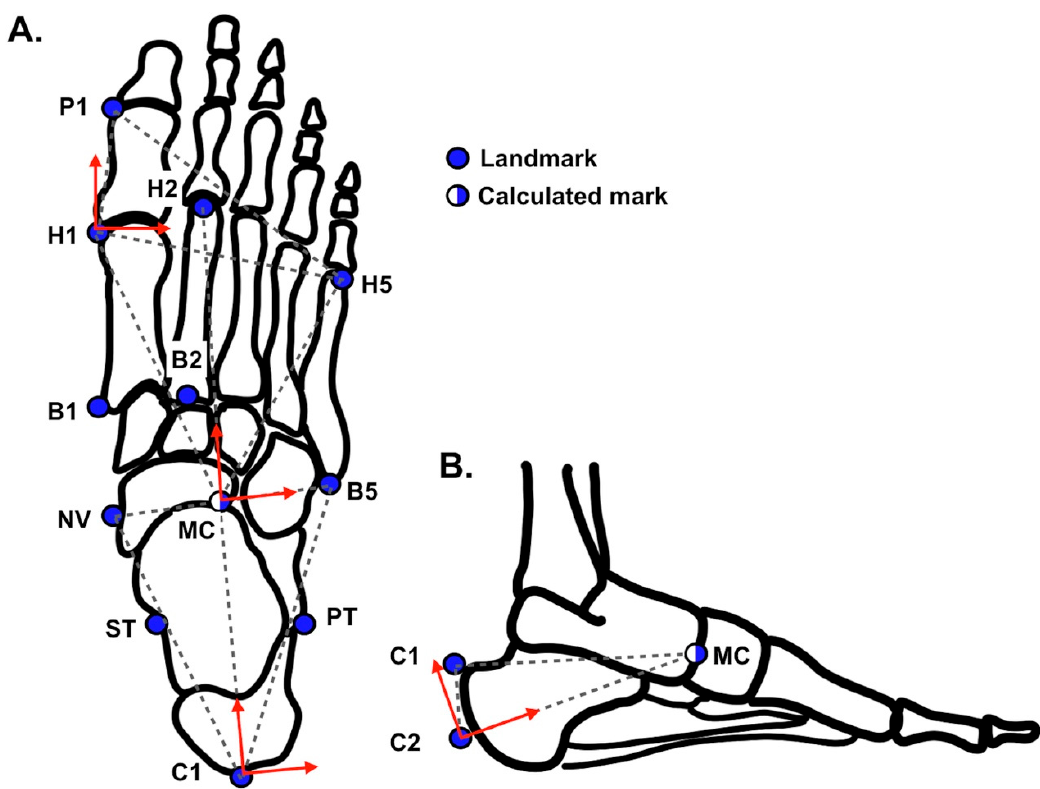
Figure 2. Marker location, segment reference planes (dash triangles), and the primary- and tertiary-axis (red solid arrows) on these planes are shown. Rear-foot segment references in the planes of two conditions; transverse plane ( A ) and sagittal plane ( B ).